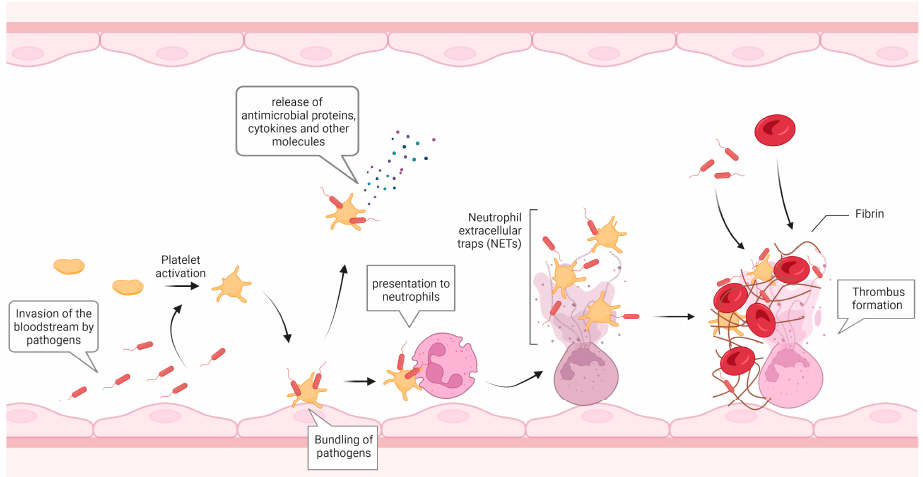
Figure 1. Schematic representation of platelet response to pathogen infection. Created with BioRender.com (Licensing number HN254B4IYS).